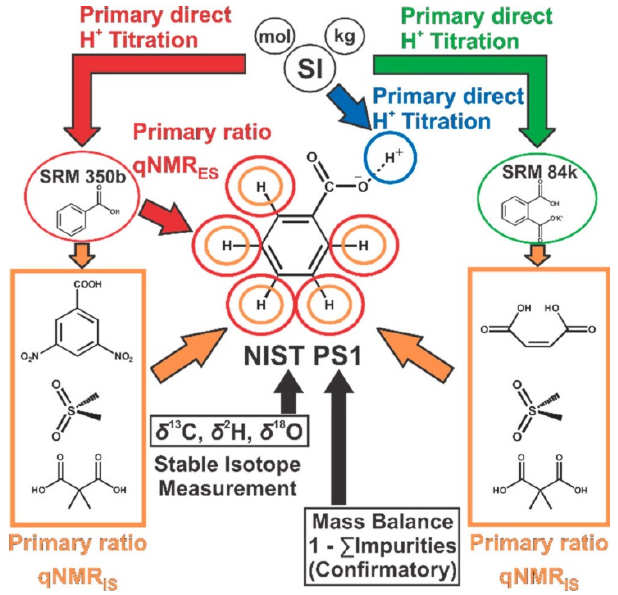
Figure 3. International System of Units (SI) traceability chain of a benzoic acid CRM (NIST PS1). Adapted with permission from [62], American Chemical Society, 2018.